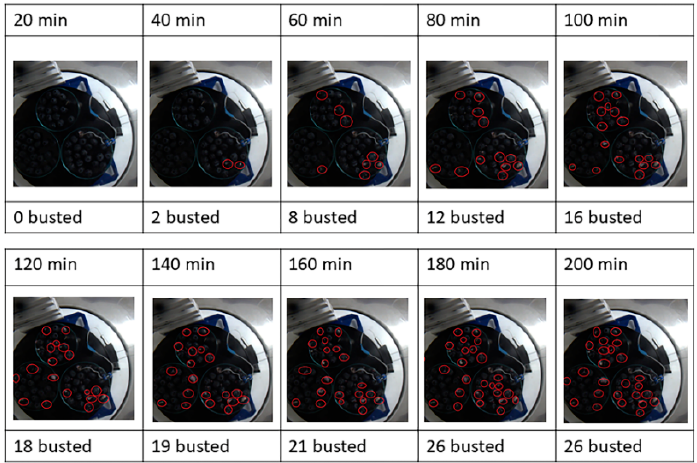
Figure 3. Visual evaluation of the busting process. Inspection of photographs taken at different times during the freeze-drying of whole nontreated blueberries.